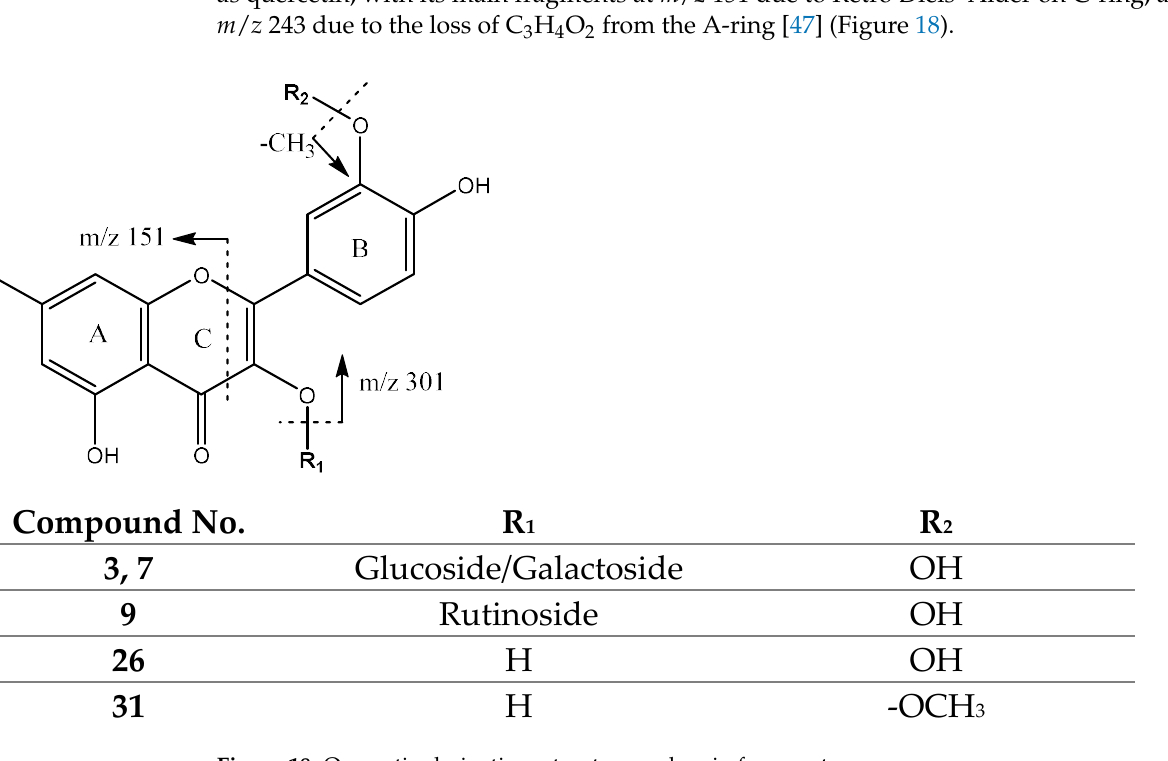
Figure 17. MS 2 spectra for ( a ) compound 9, [M-H] − = 609.1442, and ( b ) compound 31, [M-H] − = 315.0504.